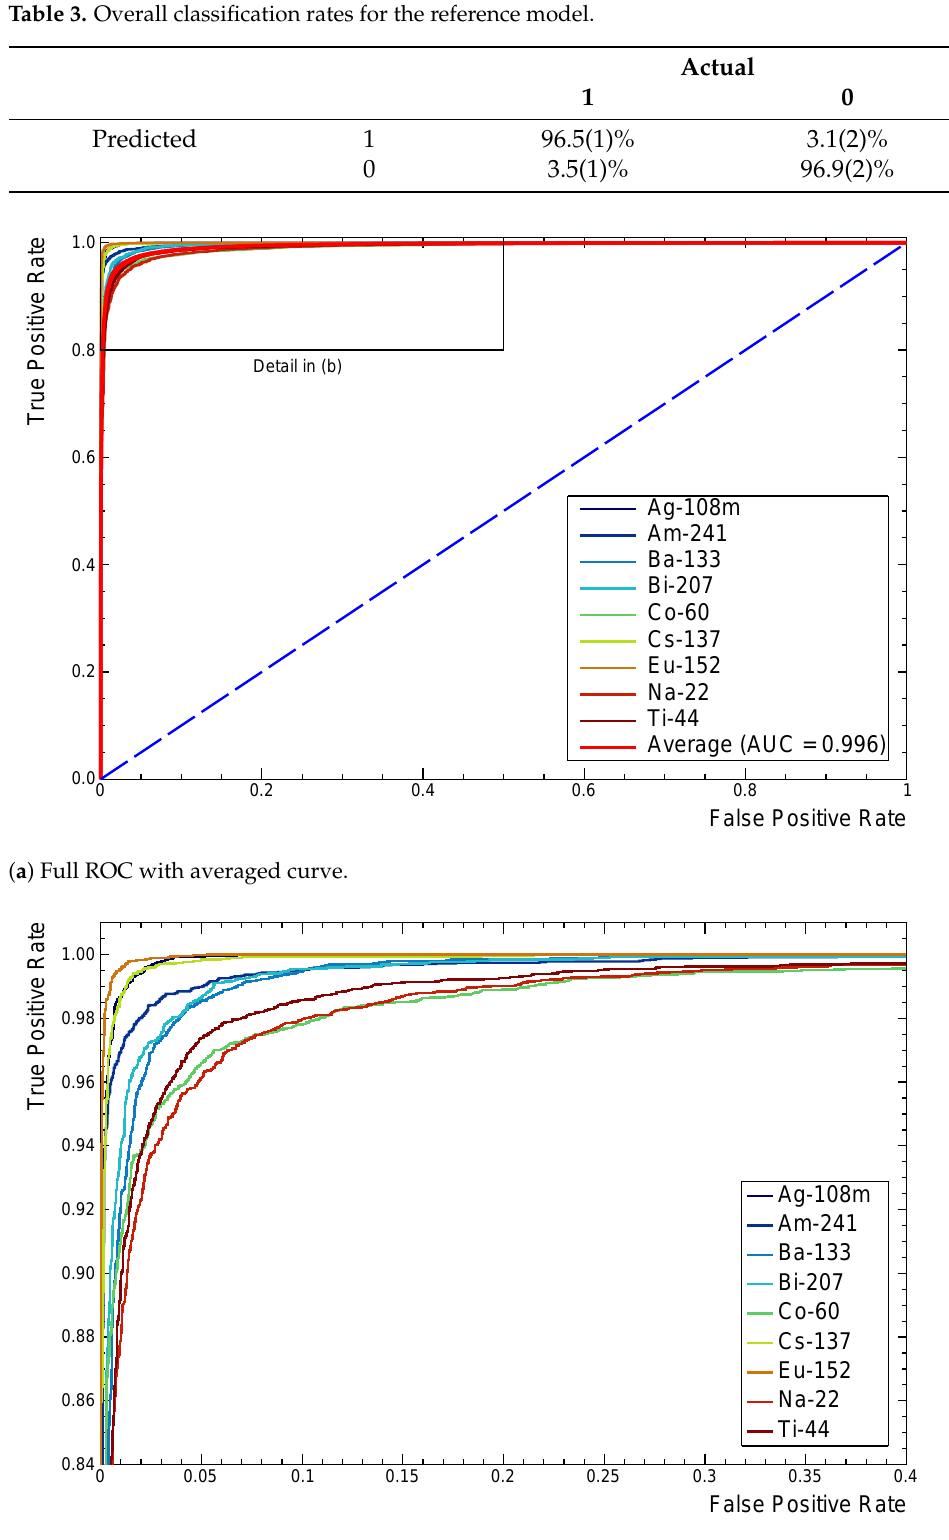
Figure 7. ROC curves extended to the multi-label case for the reference model. Provides comparisons of performance with each source as the decision threshold is varied. The average (red) is included in ( a ) as a reference for model performance across all classes. ( b ) shows 22 Na, 60 Co, and 44 Ti as marginally responsible for more false